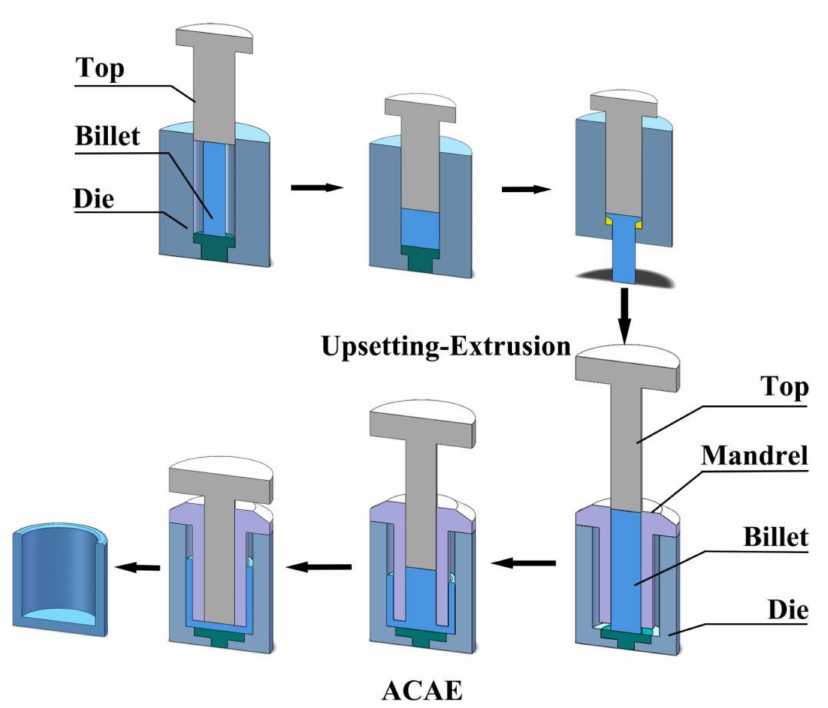
Figure 1. Schematic diagram of forming